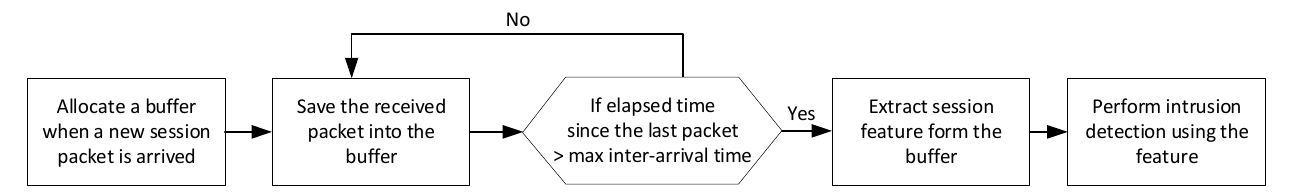
Figure 1. Typical procedure of the session-feature-based-NIDS to process the session. Table 2. Advantages and disadvantages of session-feature-based